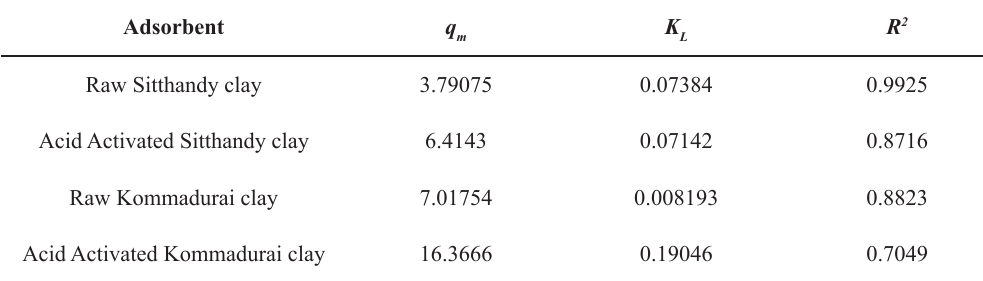
Table 1: Langmuir adsorption isotherm constants for CR adsorption.